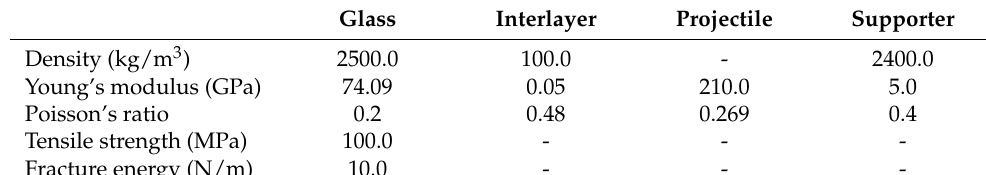
Table 3. Material properties for the FDEM analysis.